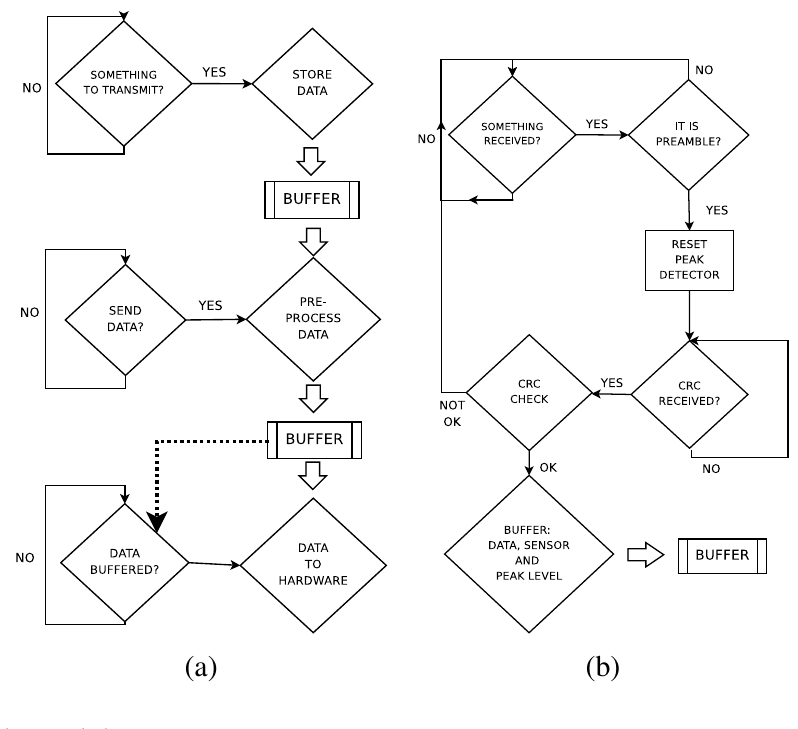
Figure 3. Block diagram of the (a) software emission module and (b) software reception